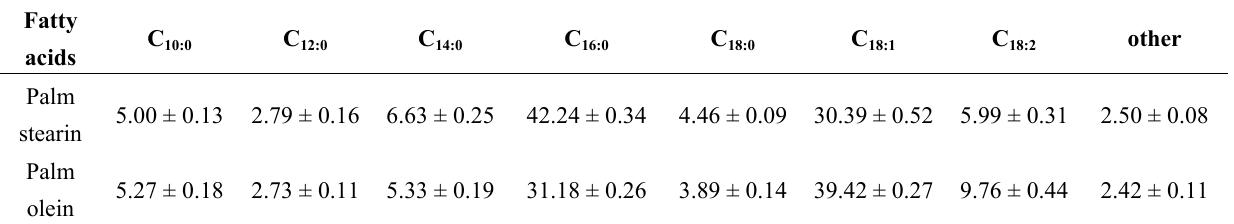
Table 1. Fatty acid composition of PS and PO